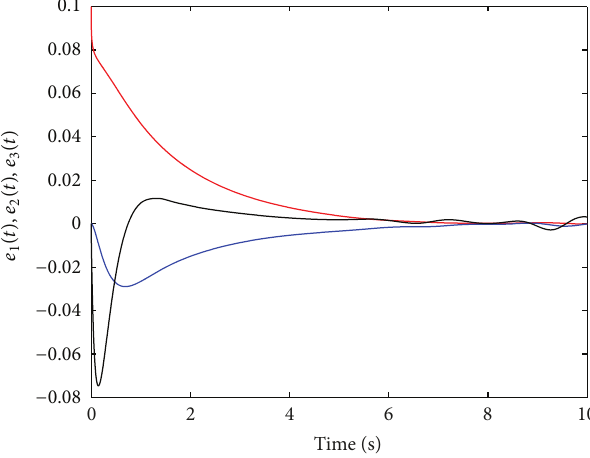
Figure 6: Synchronization errors with the control input (28) (red line represents the first error state 𝑒 1 , blue line represents the second error state 𝑒 2 , and black line represents the third error state 𝑒 3